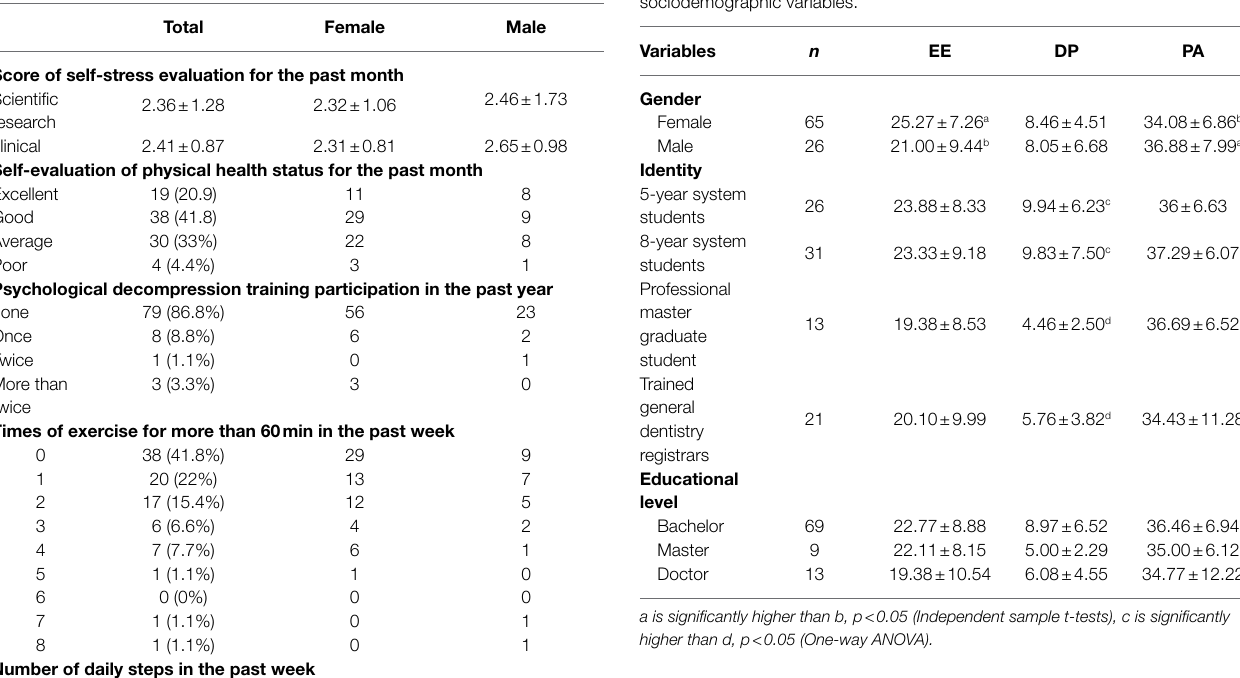
TABLE 2 | Self-stress and physical health evaluation.